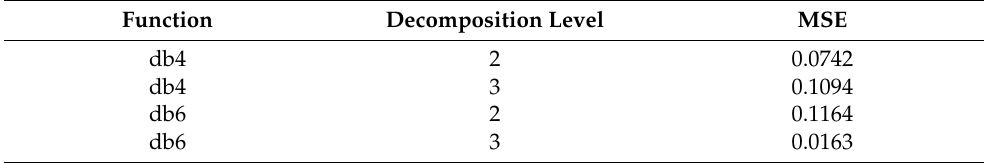
Table 4. Experimental results of different wavelet functions and decomposition levels. Function Decomposition Level